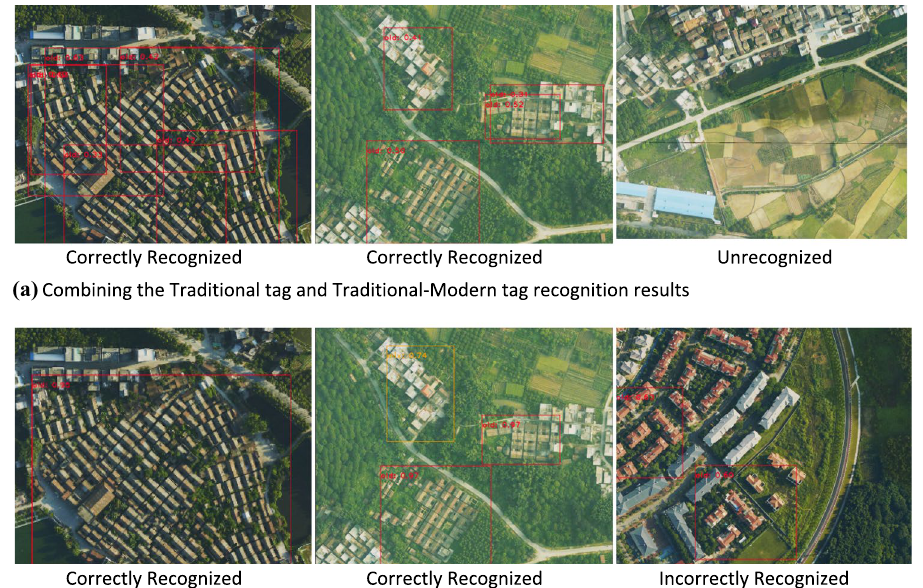
Fig. 15 Comparison of the visual results of object detec- tion network